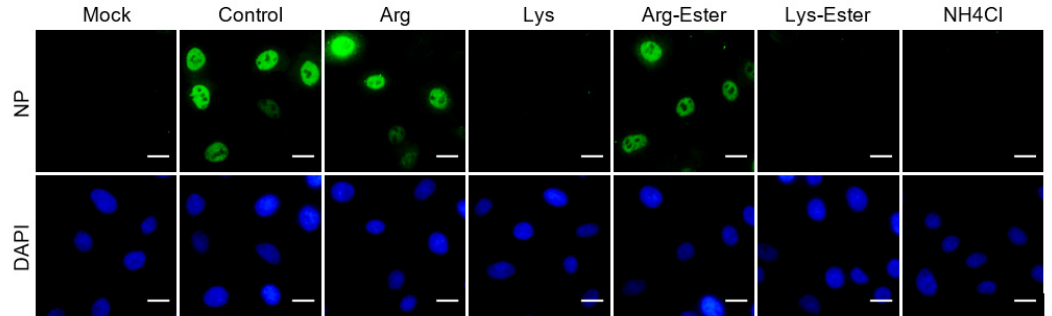
Figure 7. Compound effects on nuclear transport of IAV NP protein. A549 cells were treated with the compounds for 1 h and then infected with IAV (MOI 5) for 1 h at 37 °C in the presence of the compounds. After 3 hpi, cells were fixed and subjected to immunofluorescence staining with anti-NP antibody and Alexa Fluor 488 goat anti-mouse antibodies. Nuclei were counterstained with DAPI and cells were visualized with a fluorescence microscope. Scale bar = 20 µM.